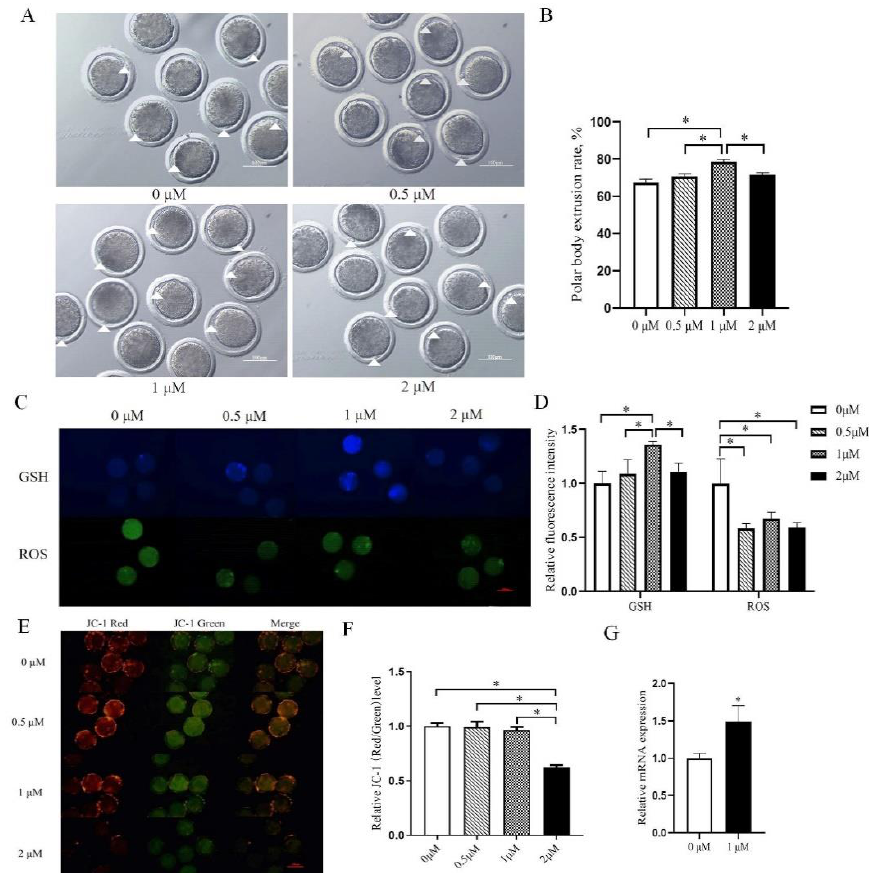
Figure 2. Resveratrol affects maturation rate, GSH, ROS, and mitochondrial membrane potential in oocytes. ( A ) Representative images of oocyte maturation after resveratrol treatment. The white triangle represents the extrusion of the polar body. Bar = 100 µ m. ( B ) The maturation rate after treatment with different concentrations of resveratrol in oocytes. ( C ) Representative images of GSH and ROS after treatment with different concentrations of resveratrol in oocytes. Bar = 100 µ m. ( D ) The relative levels of GSH and ROS in oocytes after treatment with different concentrations of resveratrol. ( E ) Red and green fluorescent images of JC-1 staining after treatment with different concentrations of resveratrol in oocytes. Bar = 100 µ m. ( F ) The relative level of JC-1 after treatment with different concentrations of resveratrol in oocytes. ( G ) Sirt2 mRNA level after 1 µ M resveratrol treatment. The graph shows the mean ± SEM of the results obtained in three independent experiments. *, significant difference ( p < 0.05).